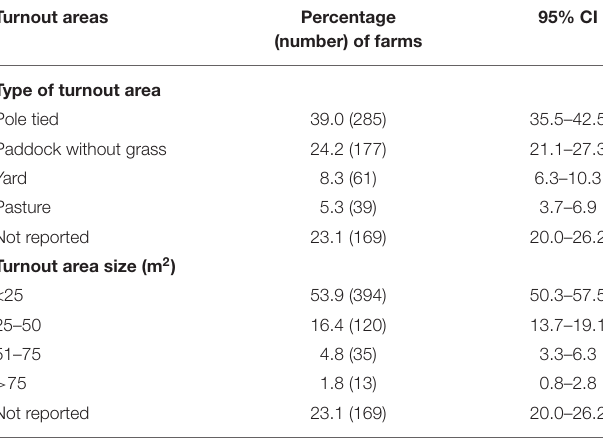
TABLE 5 | Types and sizes of turnout areas across smallholder farms in Western Liaoning and Eastern Inner Mongolia of China ( n =